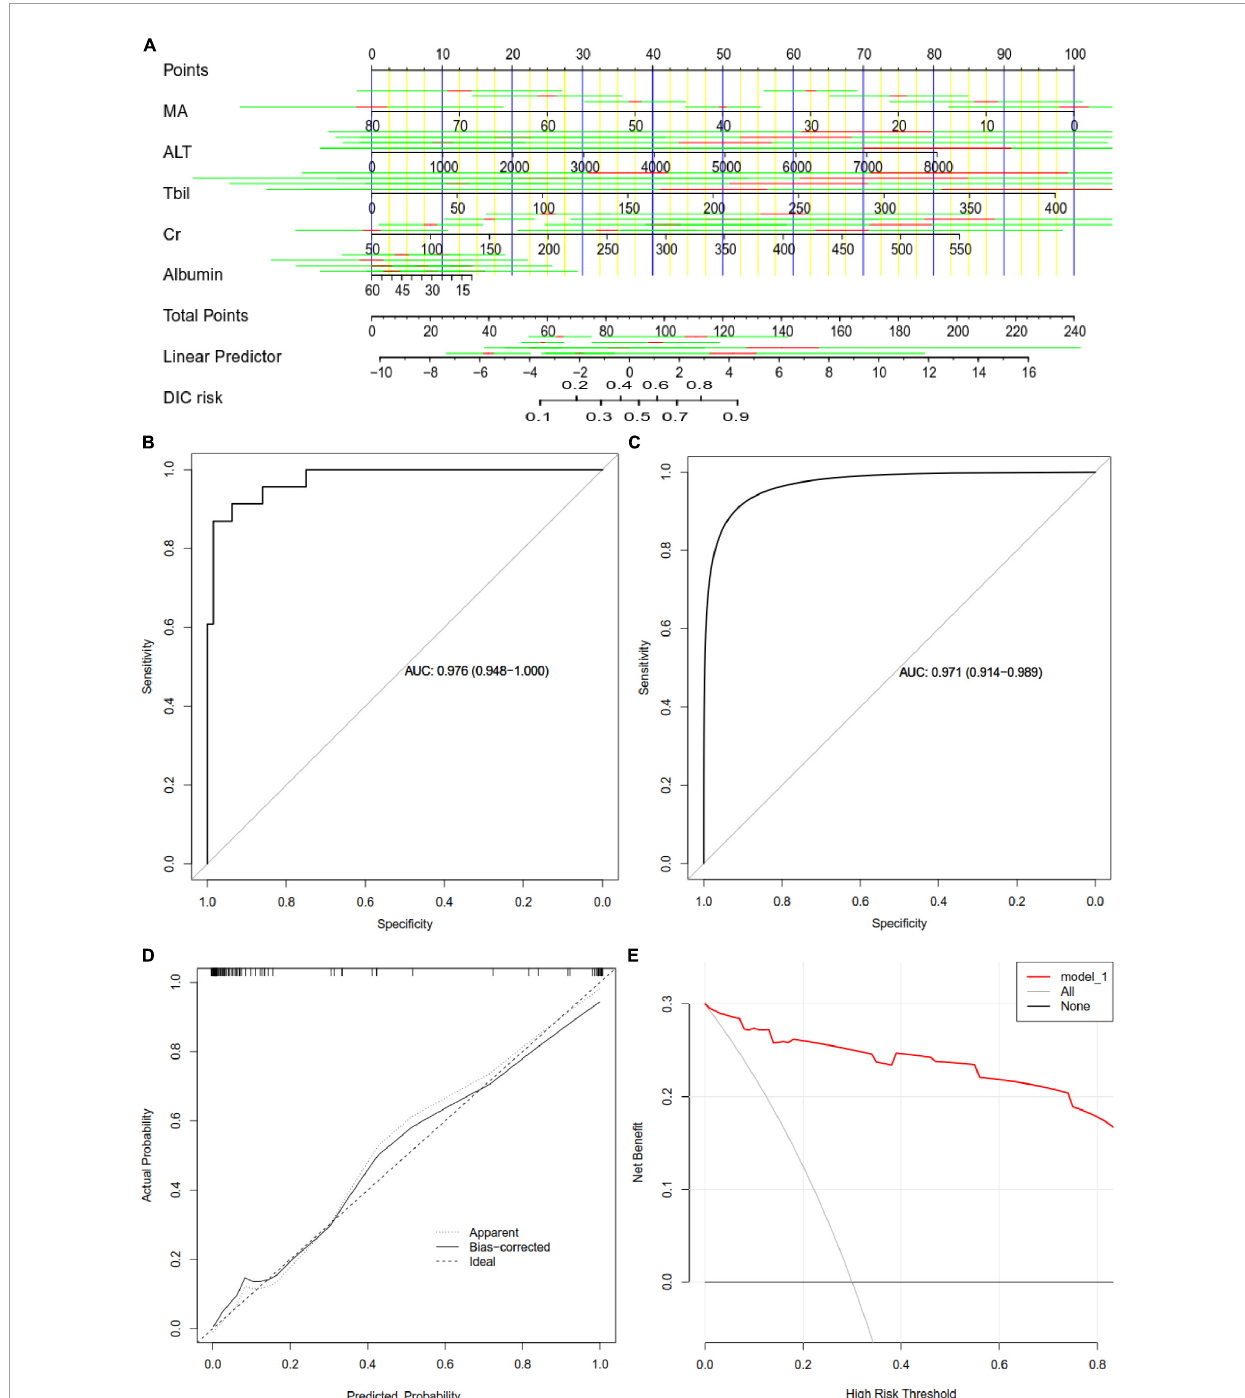
FIGURE6 Assessment of a nomogram based on five predictors of disseminated intravascular coagulation (DIC) in patients with heatstroke. (A) Nomogram for predicting DIC in patients with heatstroke. (B) Receiver operating characteristic curves assessing the ability of the nomogram to predict DIC. (C) Internal validation using the bootstrap method (resampling = 500). (D) Calibration curve of the predictive model showing the degree of consistency between the predicted probability and actual probability (the Hosmer–Lemeshow test, P > 0.05, suggesting that it is of goodness-of-fit). (E) Decision curve analysis to assess the clinical benefit of the predictive nomogram. ALT, alanine transaminase; AUC, areas under receiver operating characteristic curves; Cr, creatinine; MA, maximum amplitude; Tbil, total bilirubin.